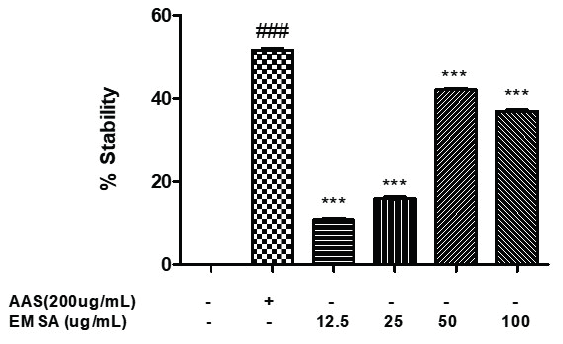
Figure 4 - Effect of EMSA on the percentage of membrane stabilization of BAlB/c mouse erythrocytes compared to the control (100% hemolysate); hemolysis assay of cells treated or not treated with eMSA at 100, 50, 25 and 12.5 g/ml or standard acetylsalicylic acid (ASA) at 200 μg/ml (### p<0.001 vs . Control; *** p<0.001 vs . ASA). ANOVA and Tukey’s